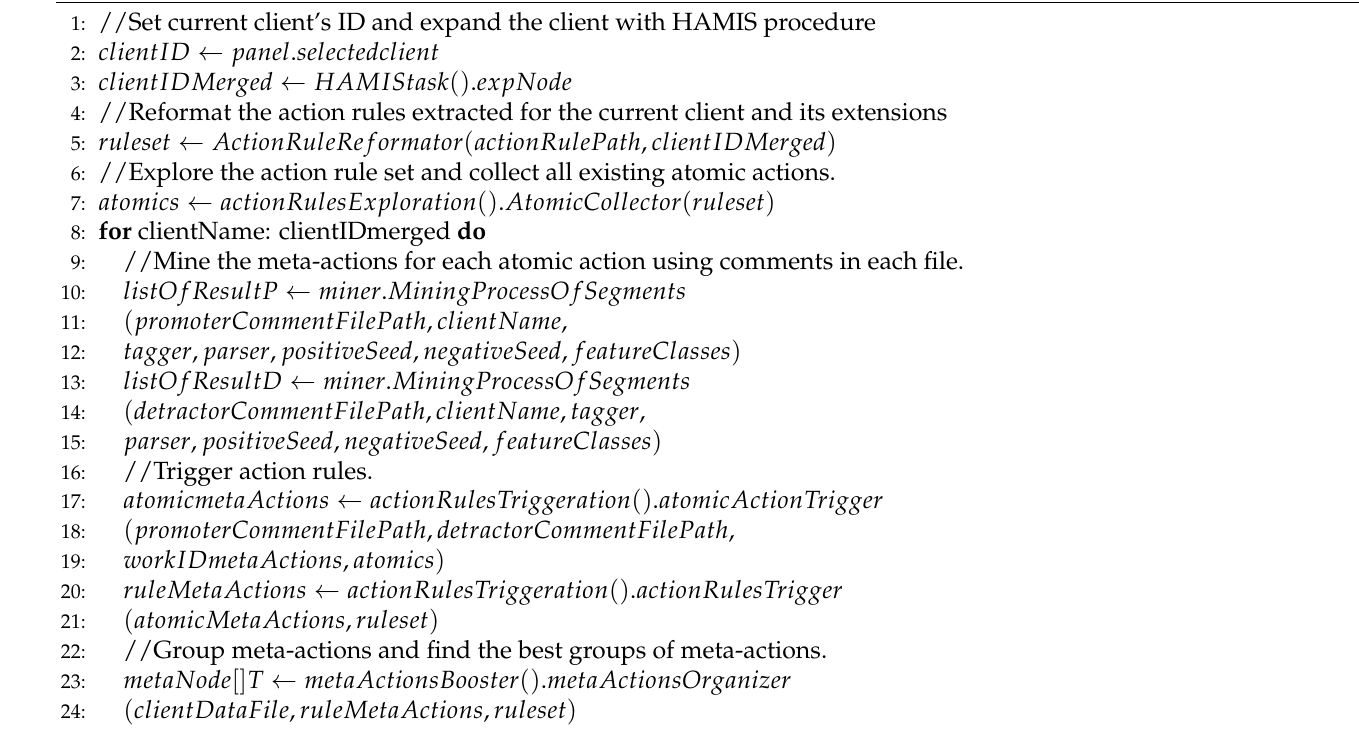
Algorithm 1 Procedure for generating data-driven recommendations.